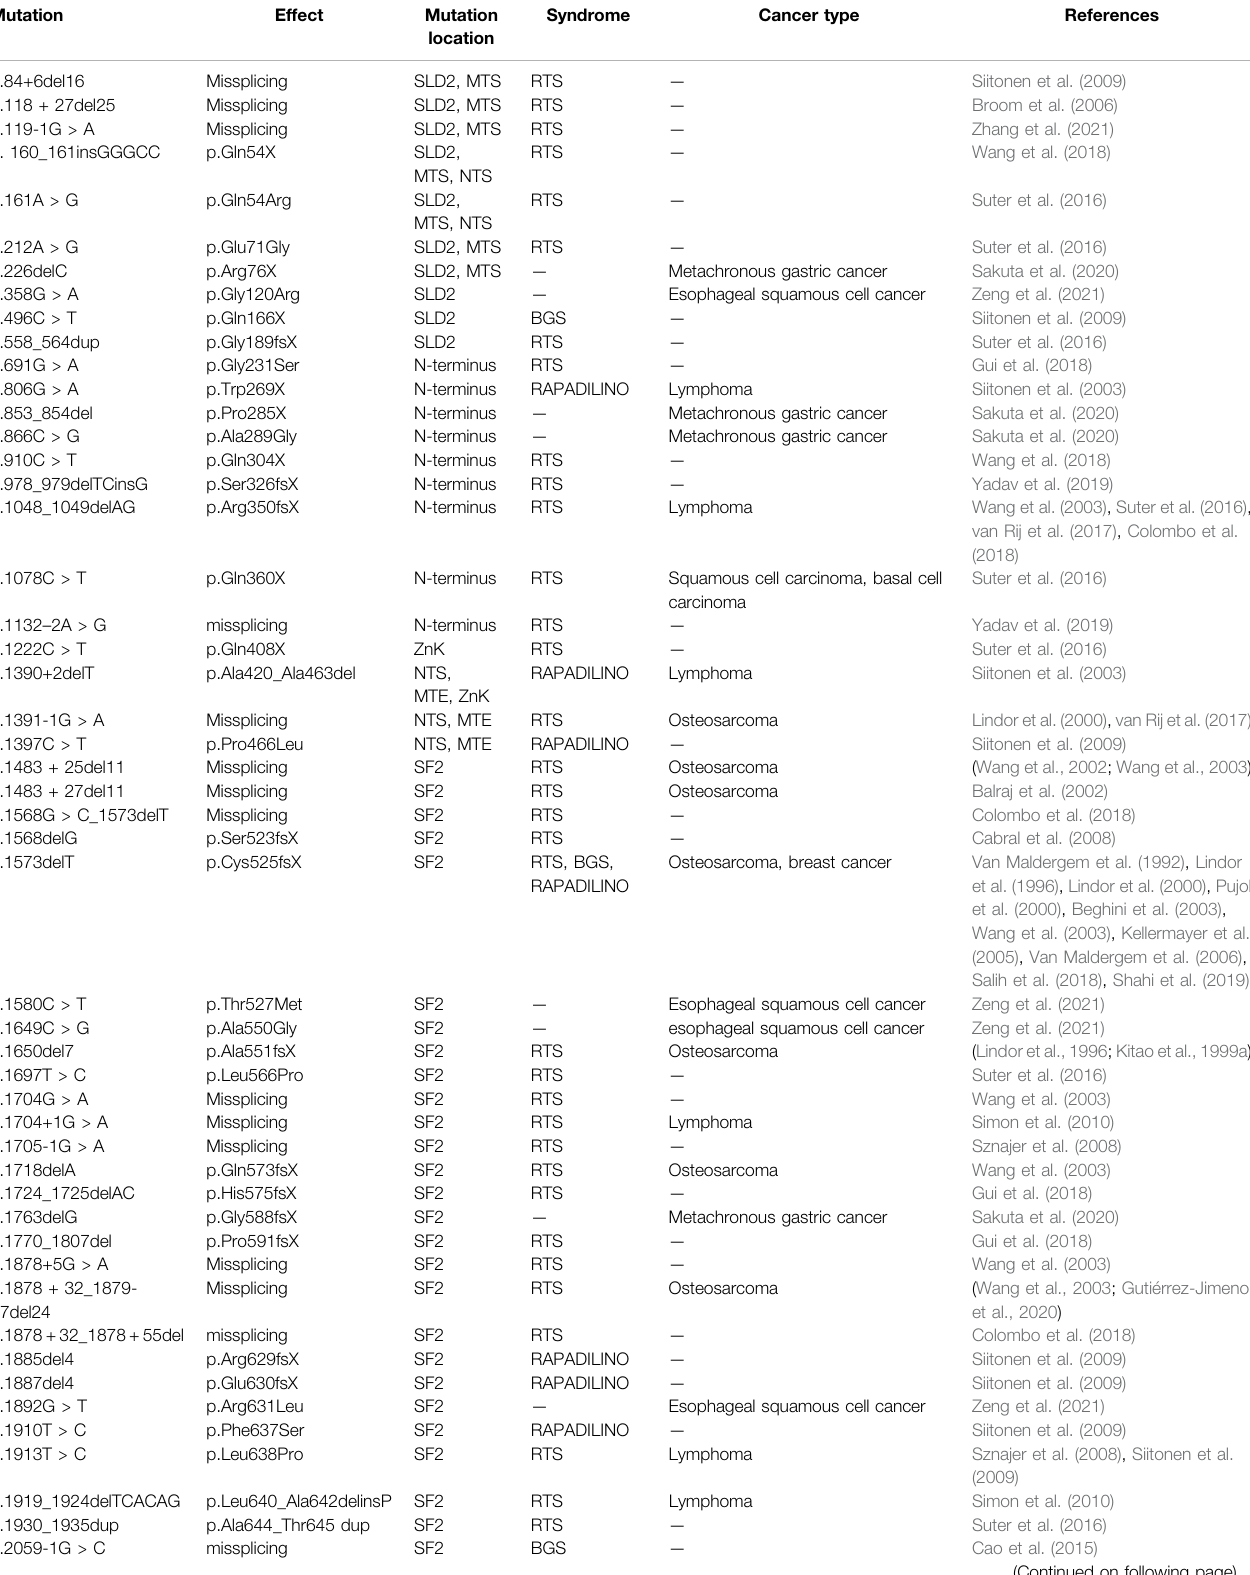
TABLE 1 | RECQ4 mutations with clinical implications. (del) deletion; ( > ) nucleotide change from; (X) premature stop codon; (dup) duplication; (fs) frameshift; (ins) insertion.